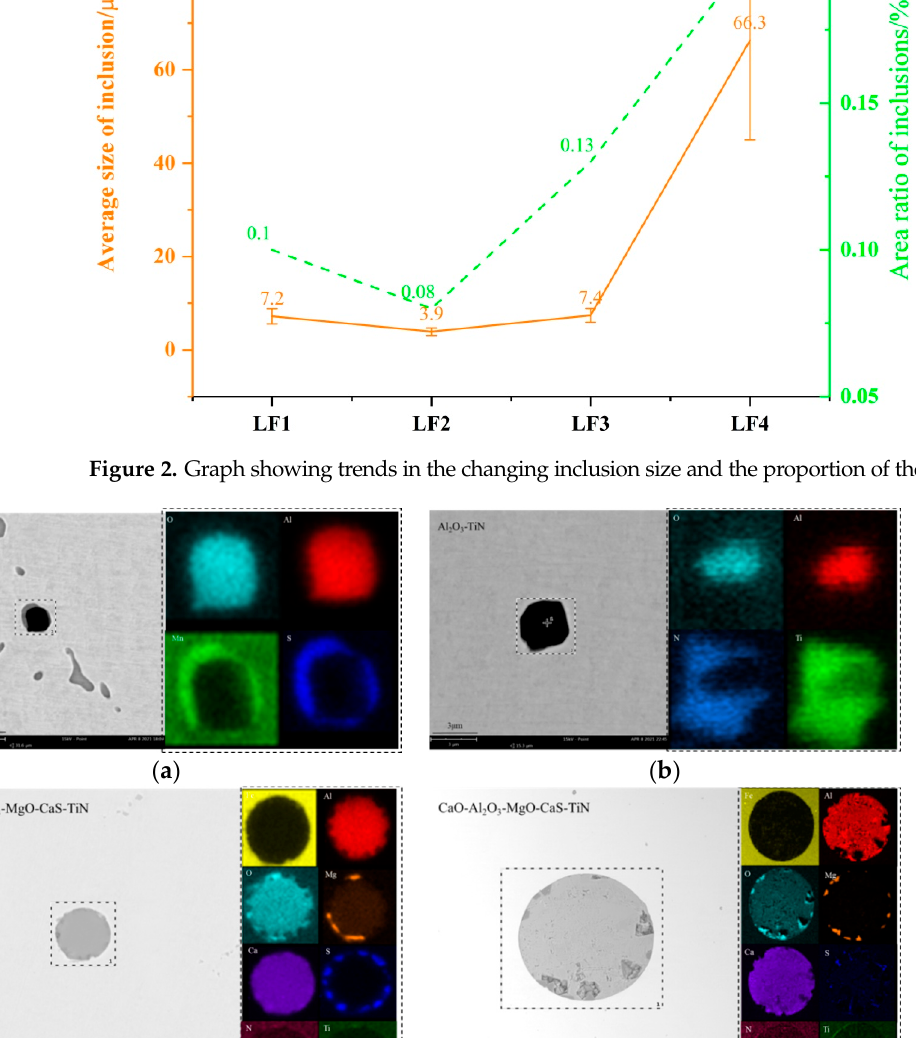
Figure 2. Graph showing trends in the changing inclusion size and the proportion of the inclusion area.